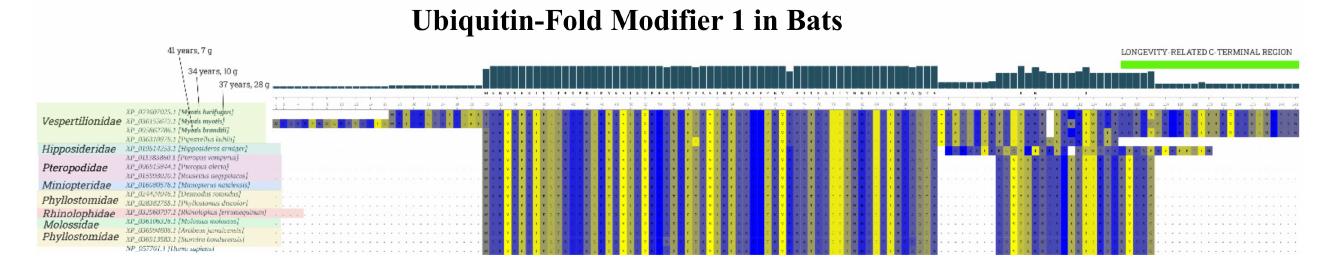
Figure 10. Sequence alignment of UFM1 proteins in bat species and humans. The 20-amino-acid-long extension of the C-terminal end in three long-living bats is depicted in light green. Multiple sequence protein alignments of UFM1 reference protein sequences were performed in MUSCLE with default parameters [47]; the colors express strand